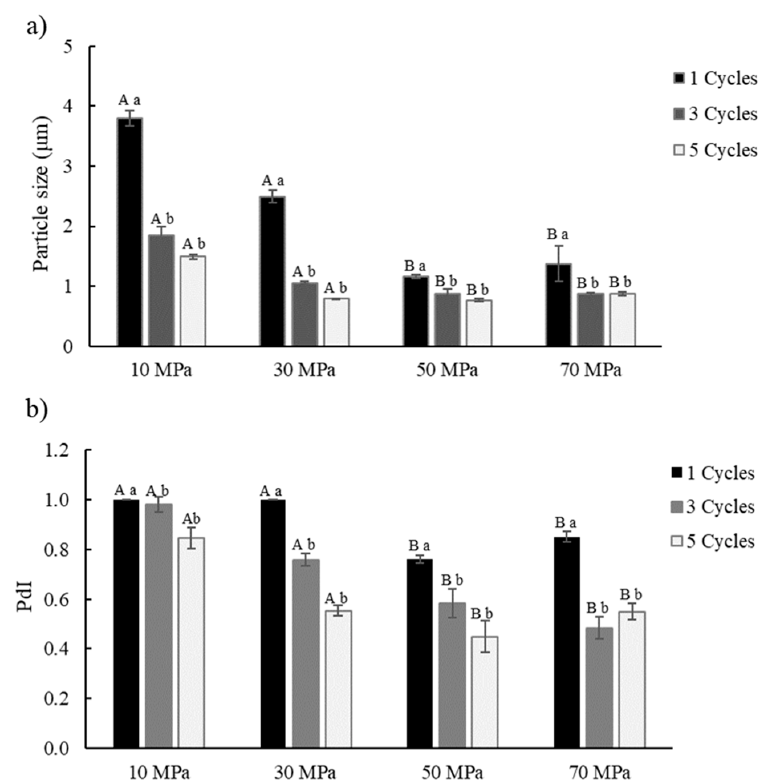
Figure 2. Effect of high-pressure homogenization (from 10 to 70 MPa) and the number of cycles (from 1 to 5) on the ( a ) particle size and ( b ) Polydispersity Index (PdI) of the primary emulsion. Different capital letters imply significant differences ( p < 0.05) between homogenization pressures. Different lowercase letters show relevant differences ( p < 0.05) between homogenization cycles.